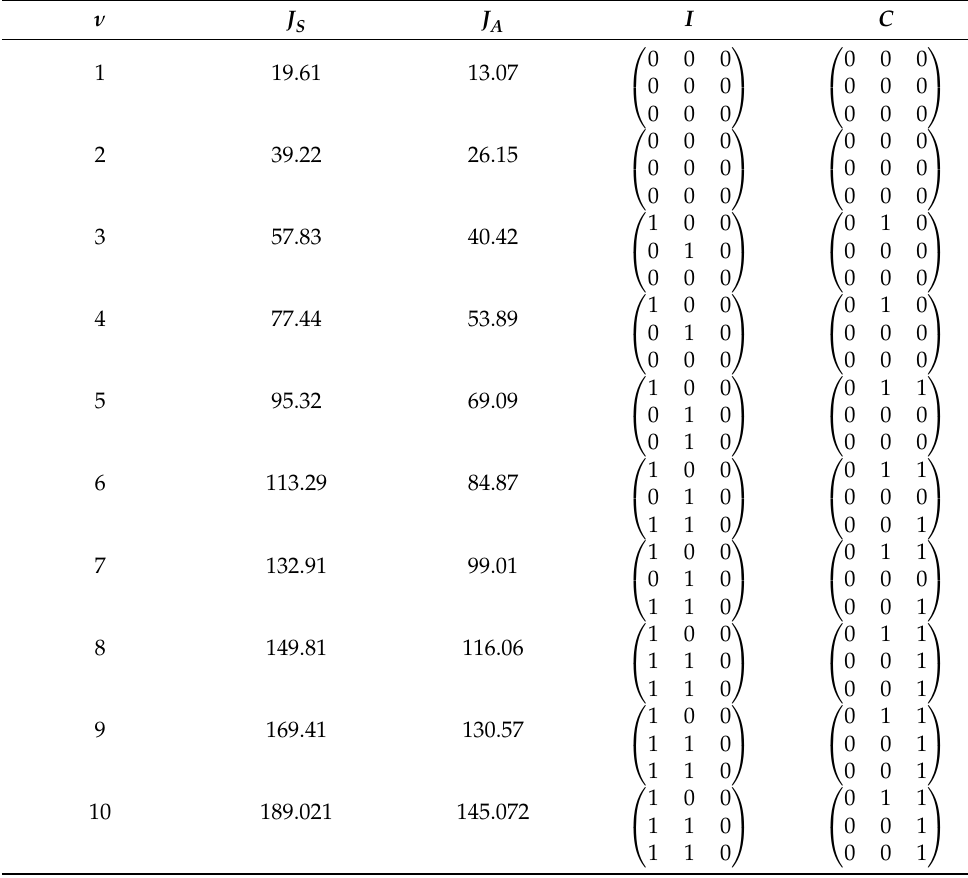
Table 7. Optimal strategies of auction participants and their payoffs depending on the bid